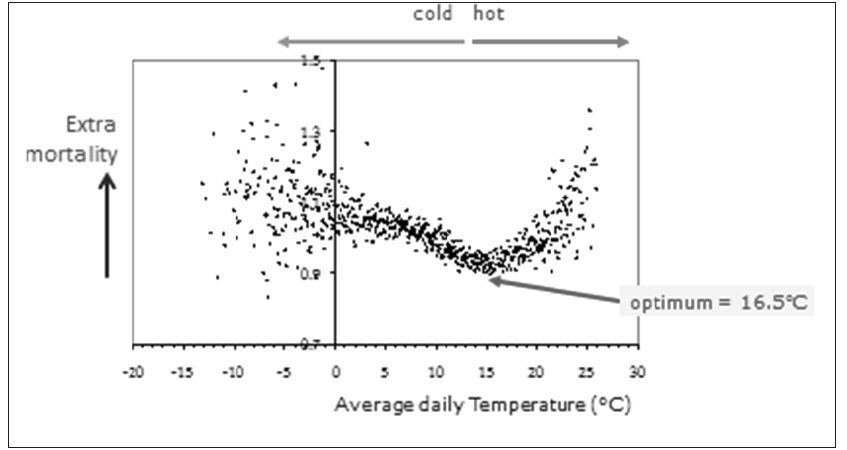
Figure 1: Relation between temperature and excess mortality. See main text for further explanation.